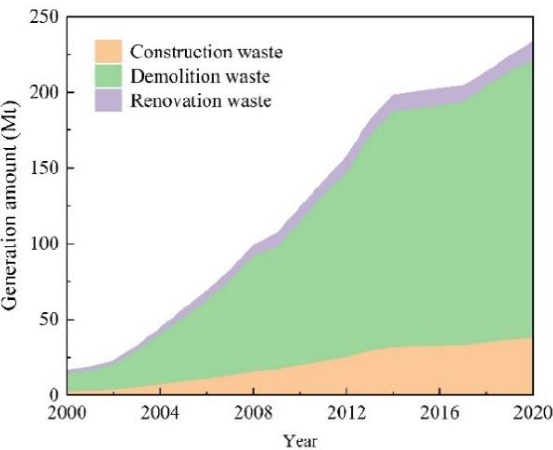
Figure 4. Estimated annual generation of CDRW in Jiangsu Province from 2000 to 2020.